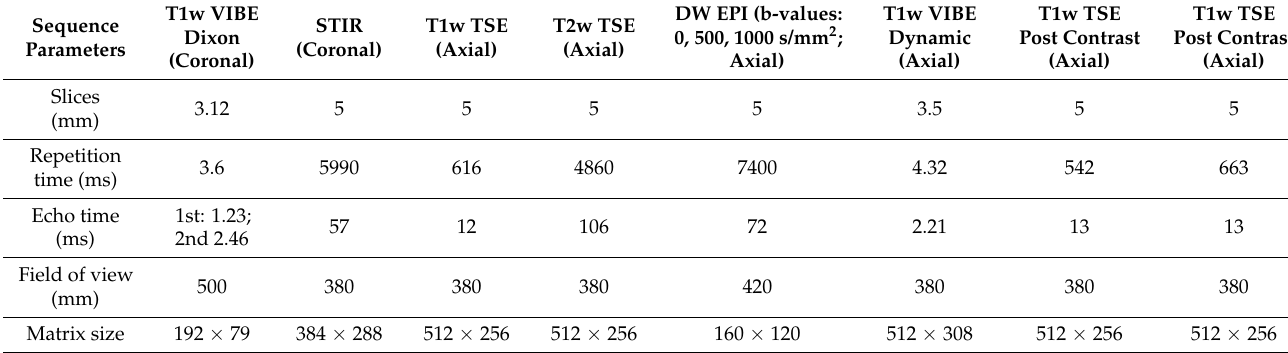
Table 1. MR imaging protocol and sequence